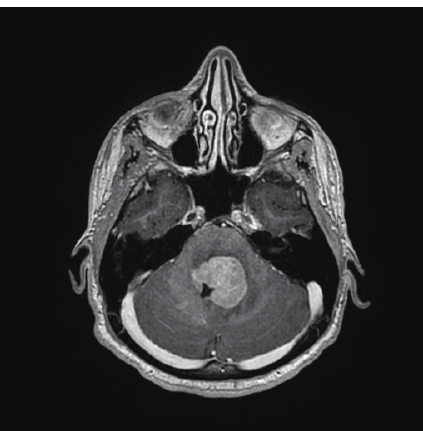
Figure 1: T1-weighted, gadolinium-enhanced axial magnetic res- onance image, showing a well-demarcated intensely enhancing subependymal lesion occluding the lumen of the fourth ventricle and causing moderate peritumoral edema.